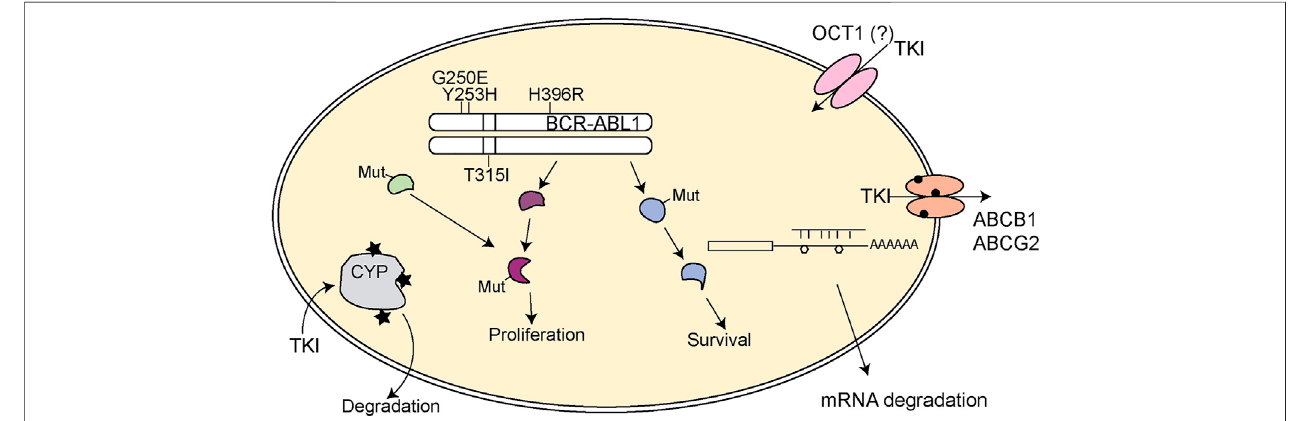
FIGURE 1 | Schematic representation of pharmacogenetic variants leading to TKI resistance in CML. Mutations in BCR-ABL1 (depicted by the protein loci of the mutation)canleadtoTKIlossoffunction.Further,mutationsindownstreamsignalingpathways(Mut)mightprovokeconstitutiveactivationofthepathwayormayleadto activation of alternative signaling pathways that undertake the signaling transduction to sustain proliferation and survival of the tumor cell. Variants in cytochrome 450 enzymes (indicated by stars) could facilitate loss of metabolism of the respective TKI and thereby impaired turnover. In addition, variants in ABCB1 or ABCB2 (circles) might lead to altered TKI ef fl ux and TKI response. The general role of the drug importer OCT1 is still controversially discussed. SNVs in mRNAs (polygons) can also lead to impaired binding of microRNAs, which itself results in altered gene expression potentially contributing to TKI resistance. TKI: tyrosine kinase inhibitor.